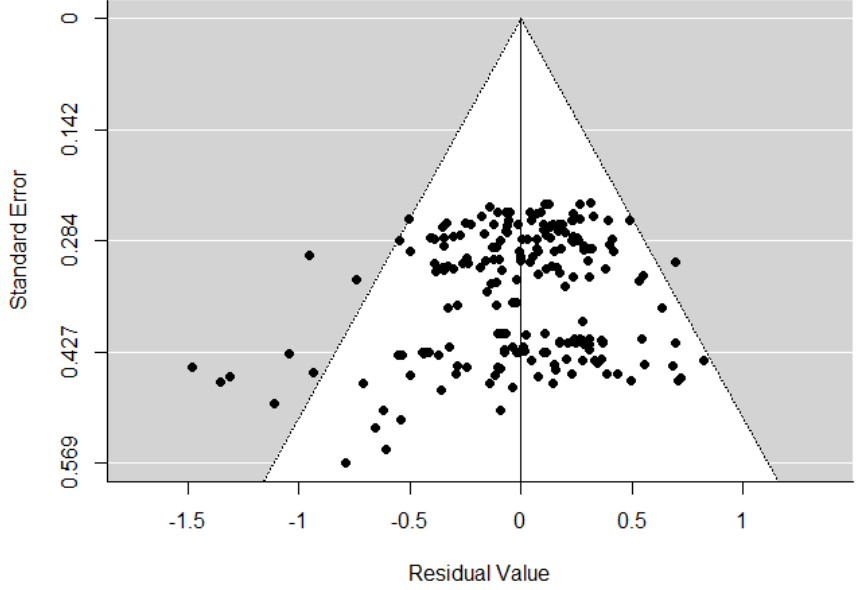
Figure 2. Funnel plot for inspection of publication bias. Residual values from the model without moderators are plotted against their standard errors.